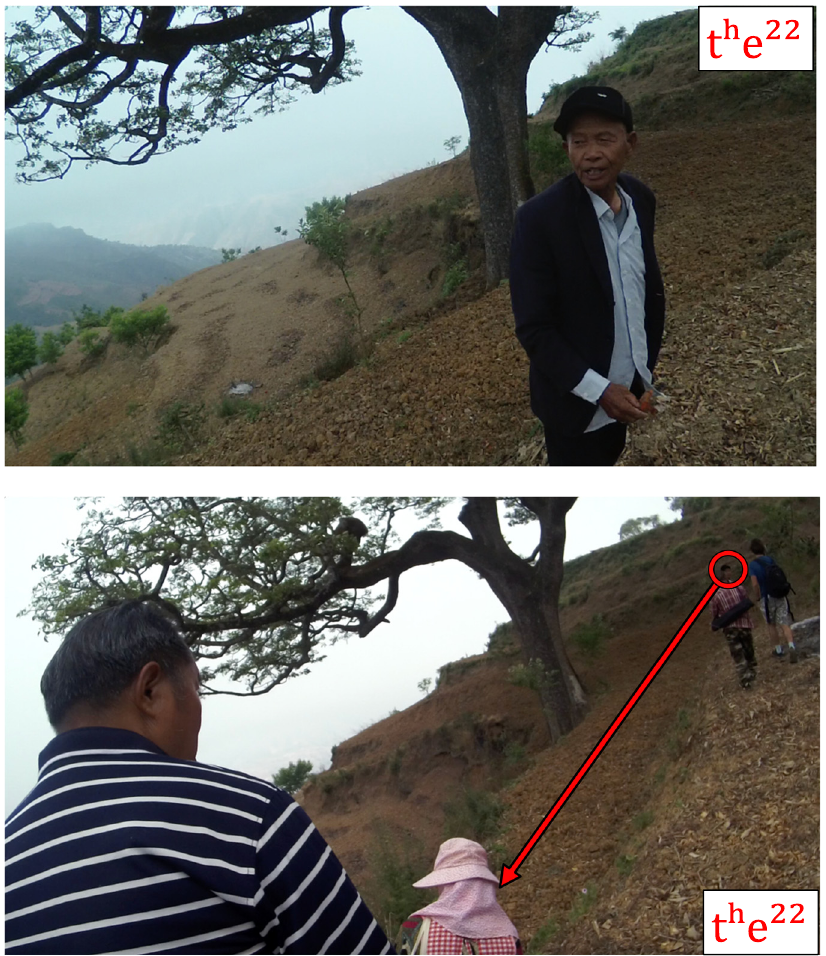
Figure 5: BLW ( red circle on the right ) monitors the location of MSN and BTL on the left. He uses addressee deictics to refer to their location. Same frame captured by di ff erent cameras ( 12 m apart )